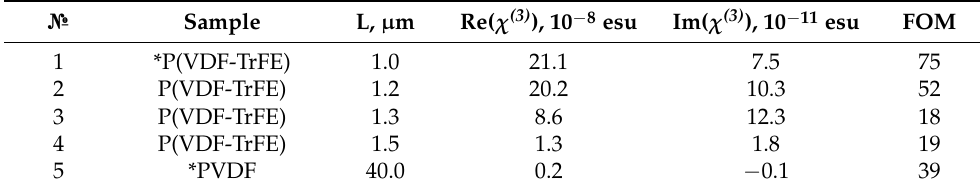
Table 1. The real Re ( χ (3) ) and imaginary Im( χ (3) ) parts of the cubic NLO susceptibility at 1064 nm for the samples of P(VDF-TrFE) copolymer with different thickness L. Asterisk “*” marks the samples without poling.